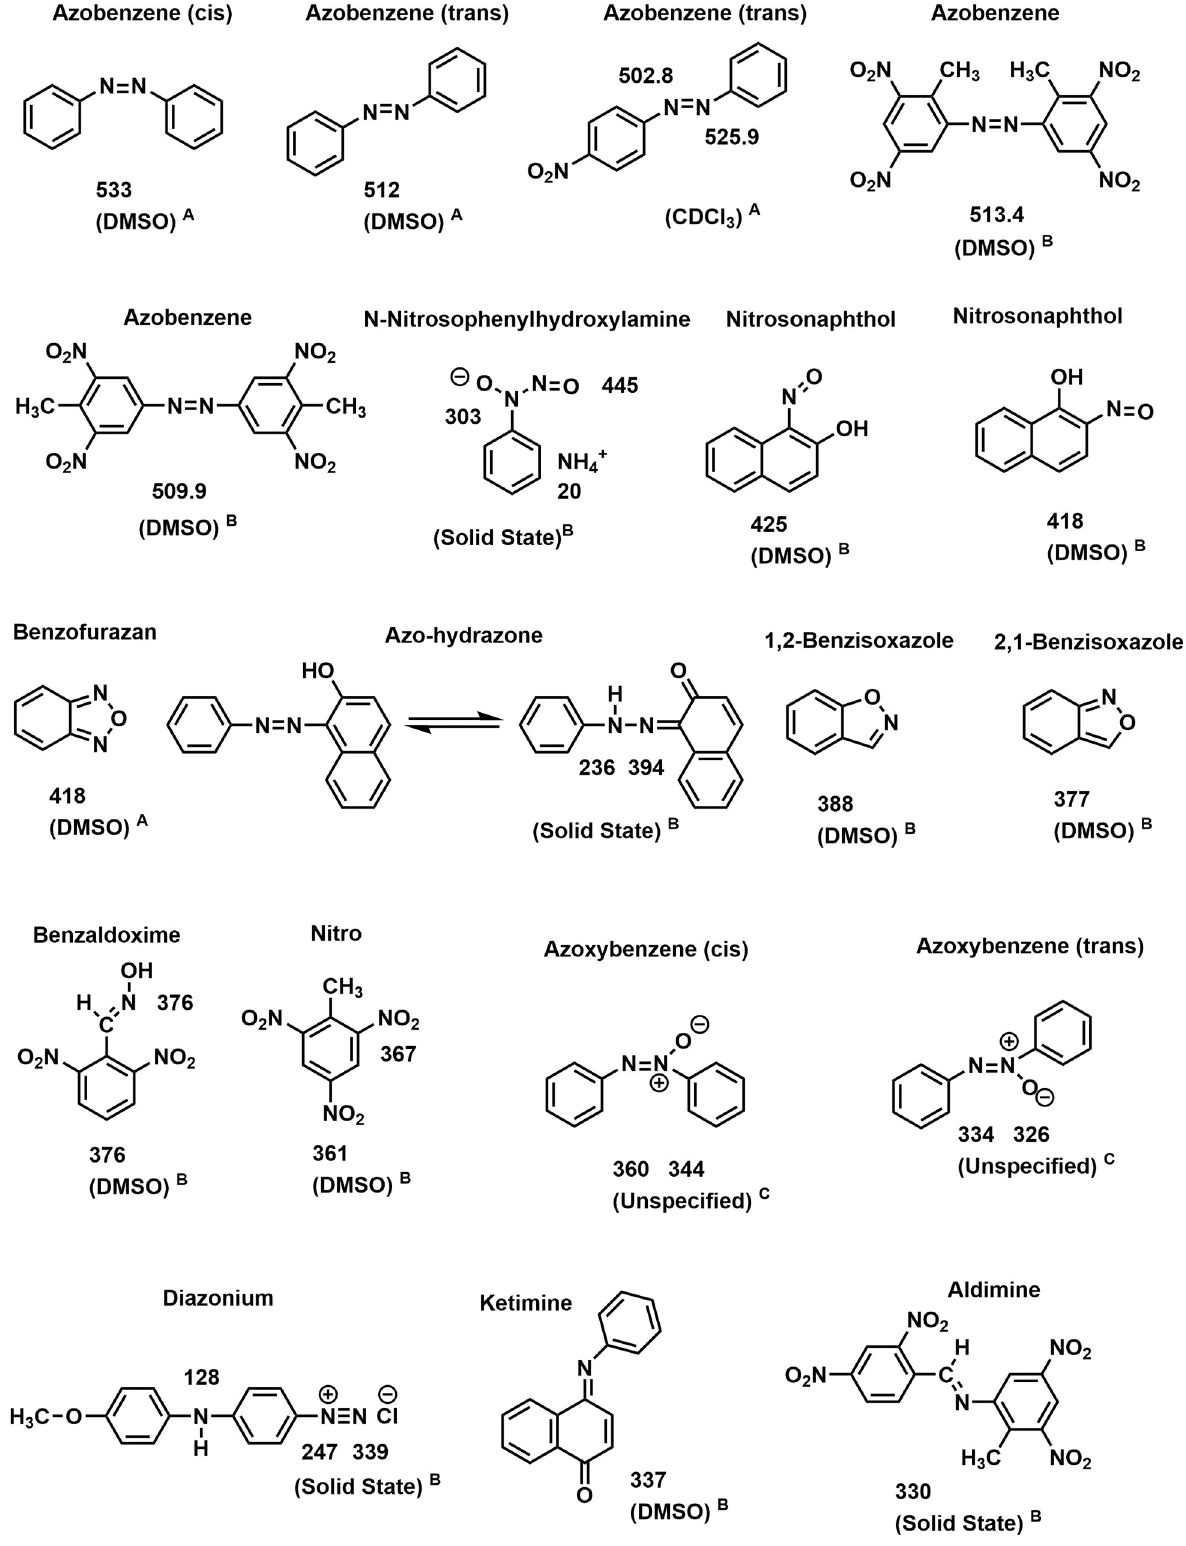
Fig 6. N-15 NMR chemical shifts of nitrogen compounds. A: Ref 73 & 76; B: Determined in this laboratory; C: Ref 75; D: Ref 74.